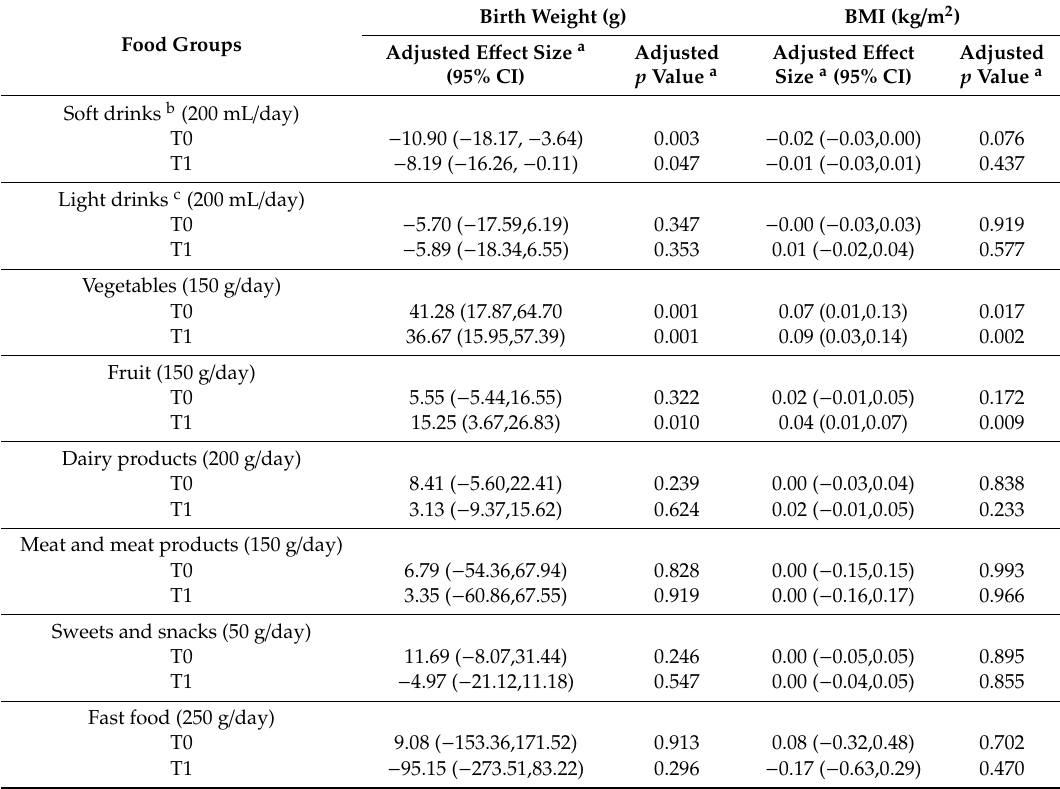
Table 2. Associations between maternal food intake and o ff spring birth weight and body mass